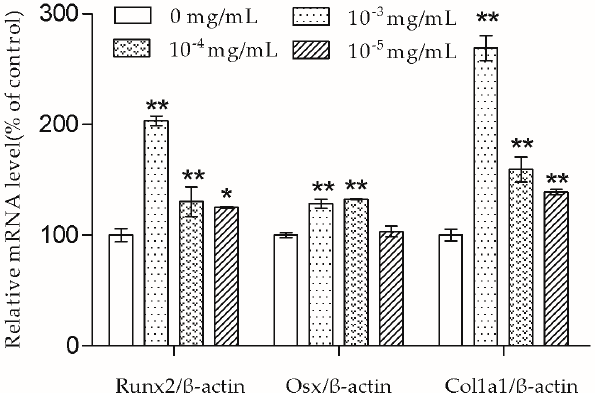
Figure 4. TSG up-regulated runt-related transcription factor-2 (Runx2), osterix (Osx), and collagen type I α 1 (Col1a1) mRNA levels of the MC3T3-E1 cells. Data are represented as the mean ± SD of three determinations. * p < 0.05 and ** p < 0.01 when compared with the control group.